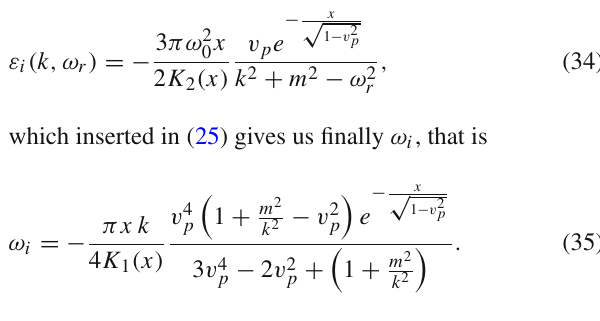
positive and much smaller than unity. We obtain a damping (cid:4) (cid:5) ¯ k ; x , ¯ m , where barred quantities are coefficient ¯ ω i = ¯ ω i intended as normalized with the proper frequency ω 0 ,